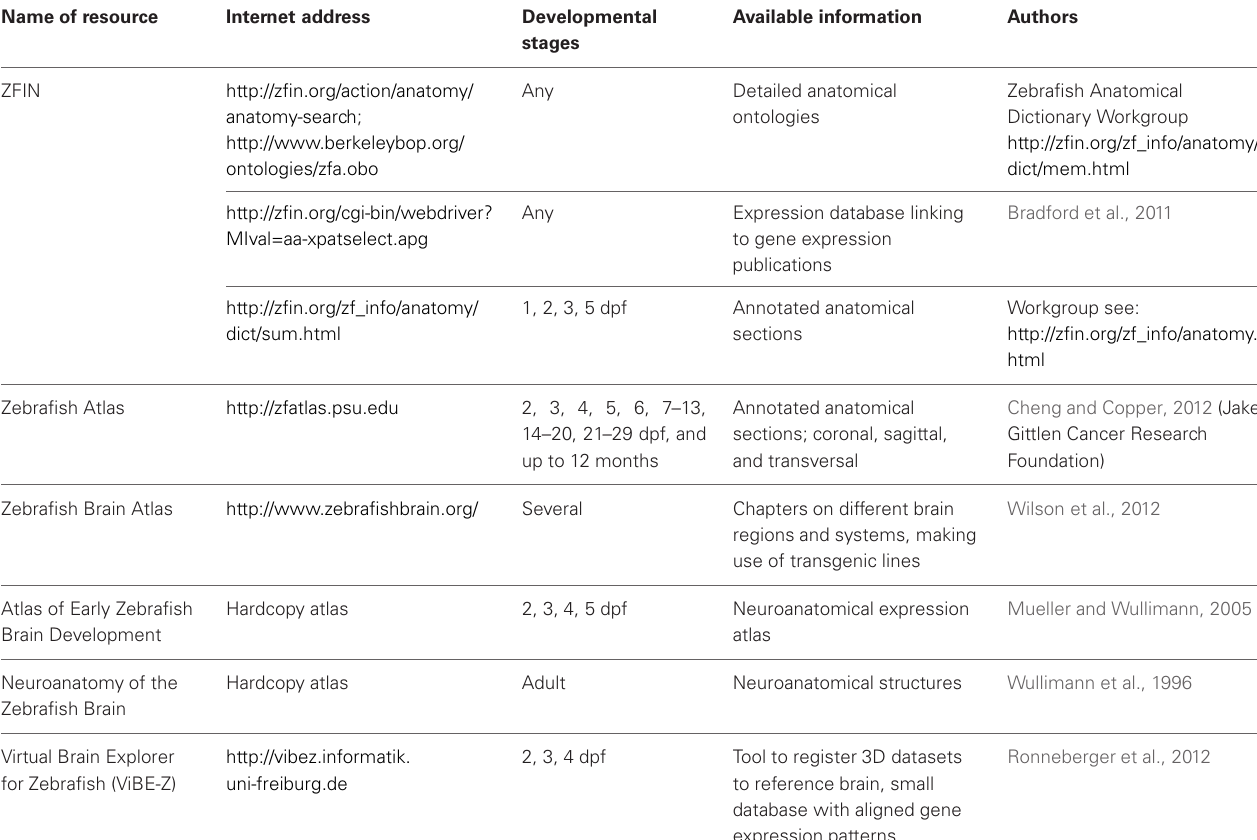
Table 1 | Selected anatomical resources for the larval and adult zebrafish